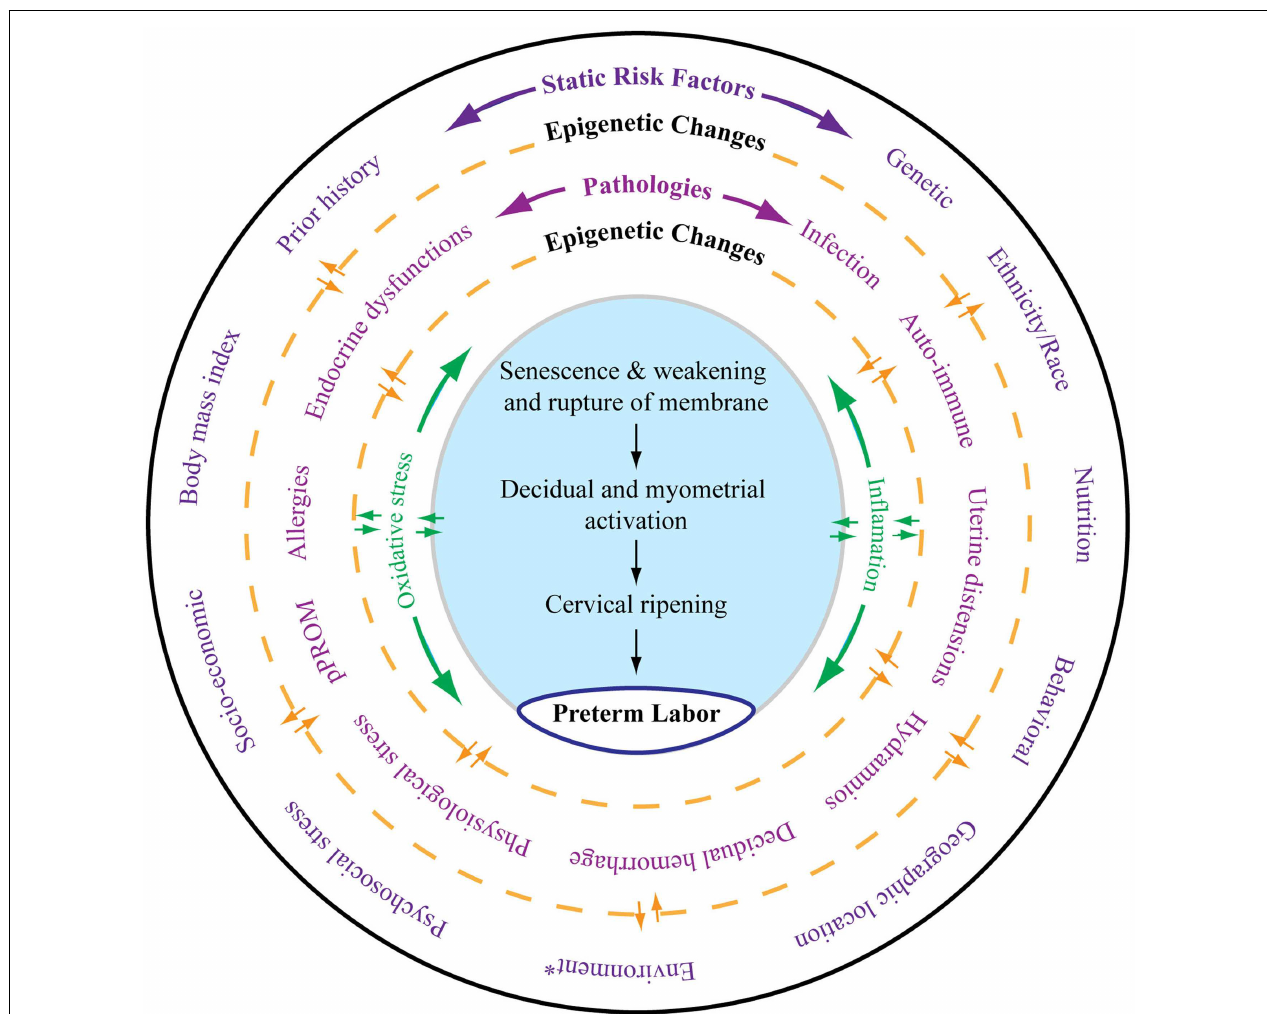
which can be independent initiators of labor-inducing pathways. All these disease processes can trigger inflammation and oxidative stress (OS). However, the extent and biomolecular characteristics of inflammation and OS are dependent on the type of risk that initiated the process, their complex interactions with the genetic–epigenetic system, and the disease that they cause.The final terminal pathways that involve inflammation and OS trigger labor-inducing signals from fetal membranes and decidua and cause cervical ripening, myometrial contractions, and membrane rupture, resulting in preterm labor and delivery. *Any exogenous factor that can impact pregnancy outcomes. Many of the static risk factors in the outer circles are also called